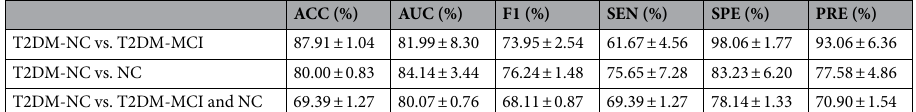
ACC (%) AUC (%) F1 (%) SEN (%) SPE (%) PRE